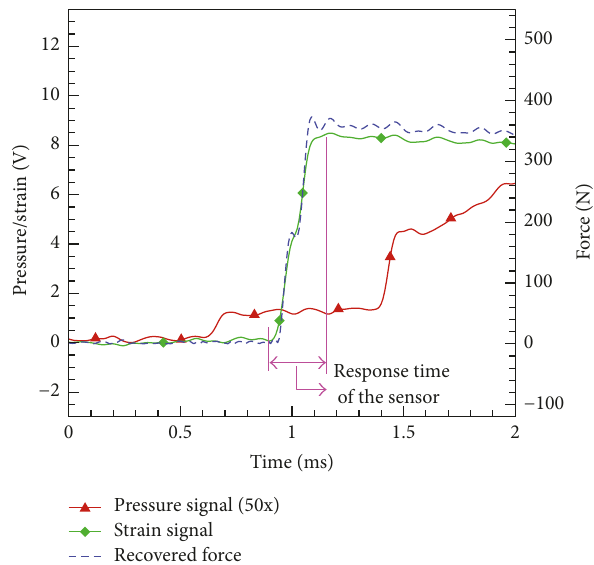
Figure 10: Experimentally obtained pressure and strain signal along with associated recovered force.